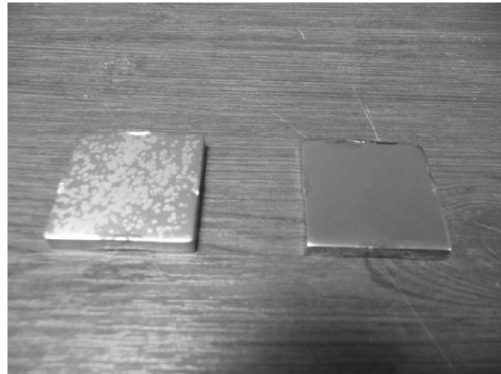
FIG. 9. E (left) and F samples after long EP experiments at 20 and 5 V. Sample E is covered with yellow spots.